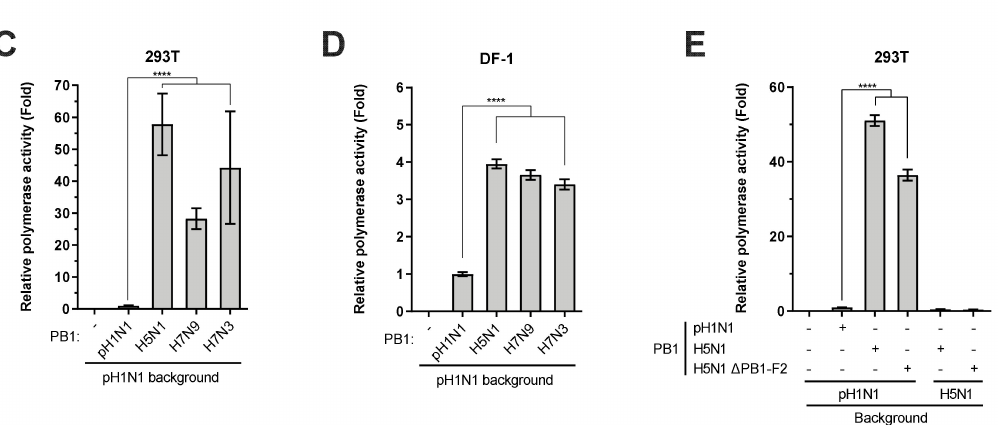
Figure 1. Avian-origin PB1 enhances 2009 pH1N1 virus polymerase activity. ( A and B ) 293T ( A )